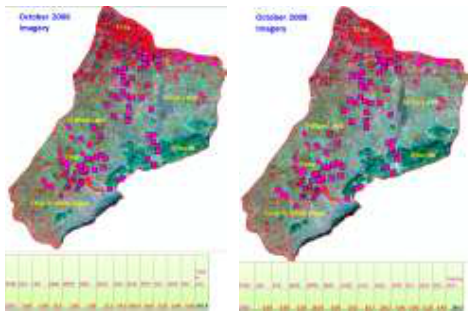
Figure-3- Change Detection between 2006 to